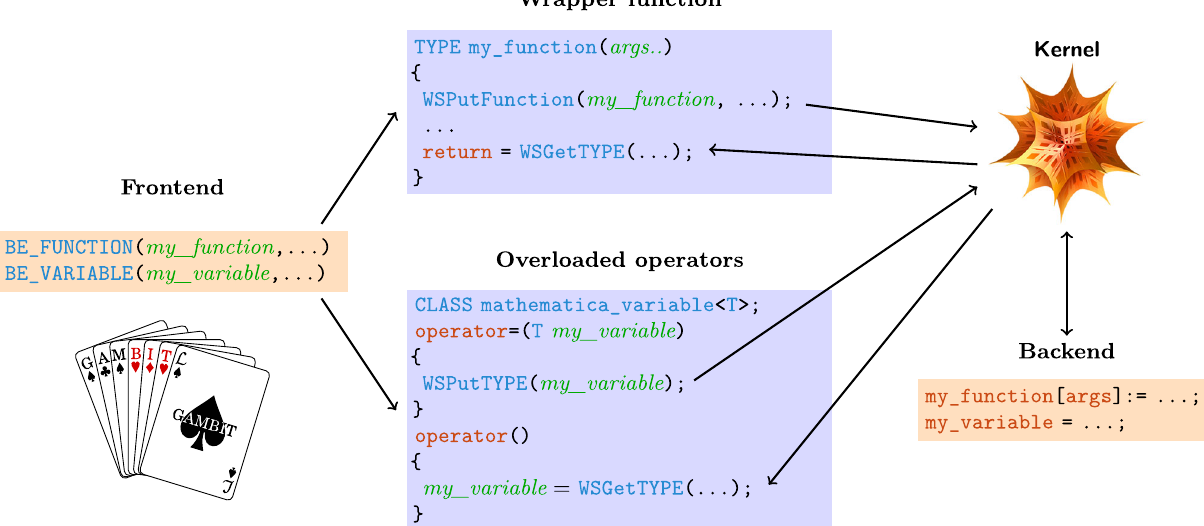
Fig. 1 Diagrammatic representation of the communication link between GAMBIT and the Mathematica Kernel , showing the wrappers for backend functions and the variable classes for backend variables the backend, and wraps it into a functor object to be handled by the dependency